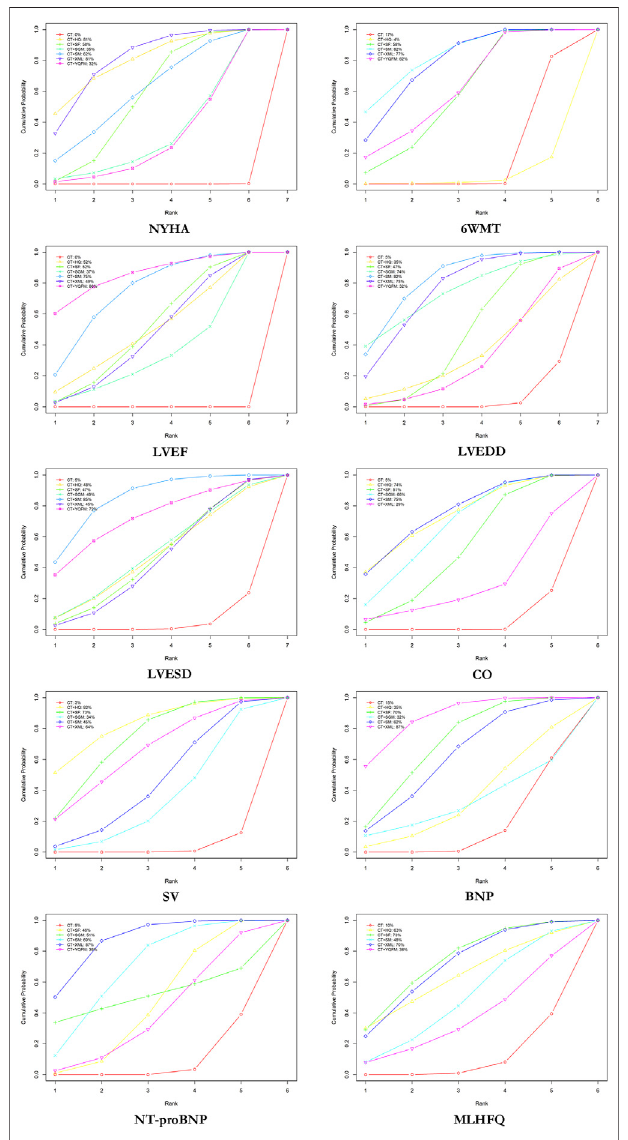
FIGURE 4 | Surface under the cumulative ranking curve (SUCRA) plots for different outcomes. The vertical axis represents cumulative probabilities and the horizontal axis represents rank. NYHA, New York Heart Association cardiac functional classi fi cation ef fi ciency; 6WMT, 6-min walking test; LVEF, left ventricular ejection fraction; LVEDD, left ventricular end-diastolic diameter; LVESD, left ventricular end-systolic diameter; CO, cardiac output; SV, stroke volume; BNP, brain natriuretic peptide; NT-proBNP, N-terminal pro-brain natriuretic peptide; MLHFQ, Minnesota Living with Heart Failure Questionnaire;CT,conventionaltreatment;HQ,Huangqiinjection;SF,Shenfu injection; SGM, Shengmai injection; SM, Shenmai injection; XML, Xinmailong injection; YQFM, Yiqifumai lyophilized